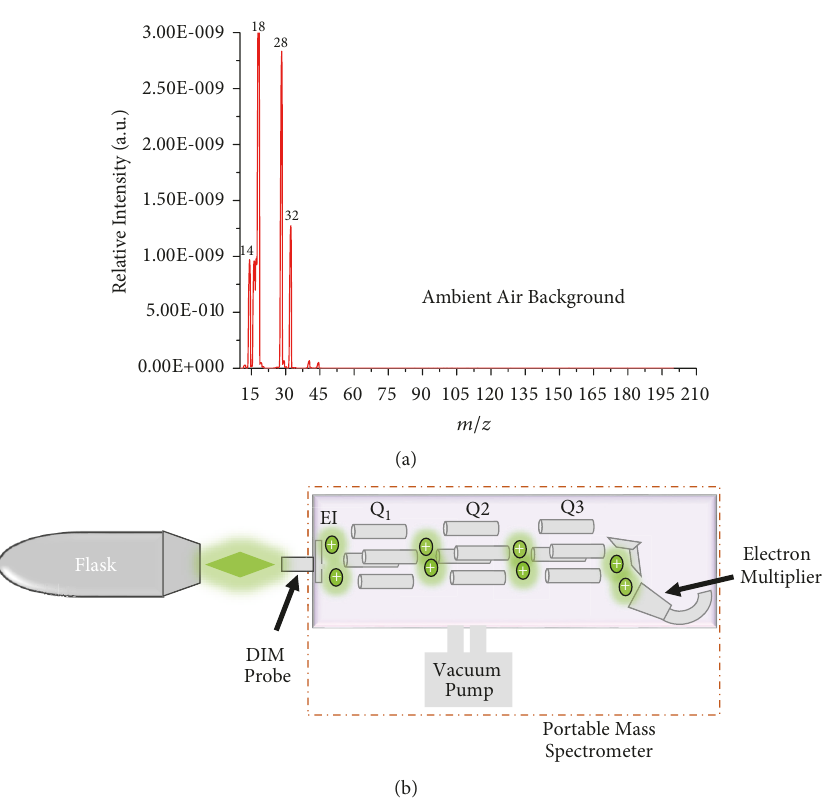
Figure 1: Experimental setup used in the detection of different fragrance formulations using a portable quadrupole mass spectrometer coupled with the a direct membrane (DIM) probe; (a) shows the mass spectra obtained for ambient air background without any sample in the flask and (b) the schematic of the portable mass spectrometer coupled to a DIM probe with a flask placed in front of the